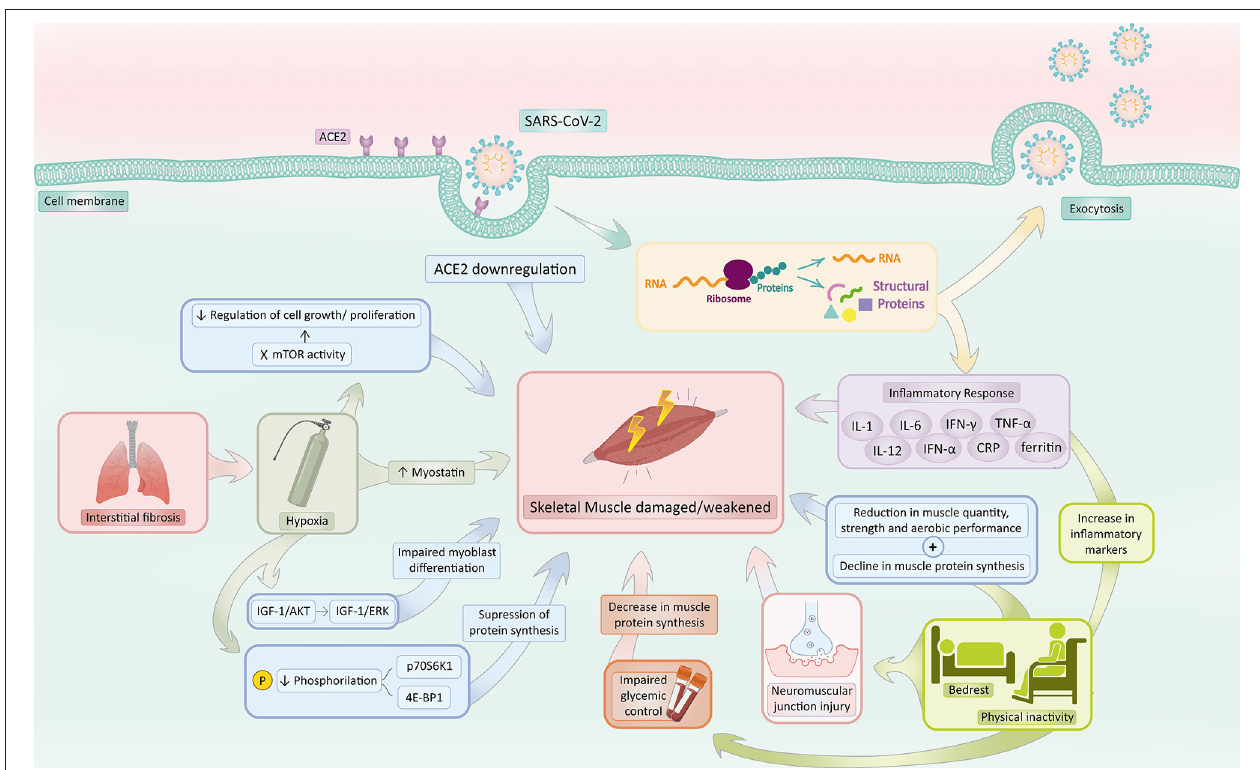
FIGURE 2 | COVID-19 associated sarcopenia mechanisms. SARS-CoV-2 infection activates a series of mechanisms responsible for increasing the risk of sarcopenia development. COVID-19 induces ACE2 downregulation and hinders the ACE2 protective effect, predisposing skeletal muscle to sarcopenia. The inflammatory response in response to infection, mainly characterized by the production of IL-1, IL-6, IFN- γ , TNF- α , IL-12, IFN- α , CRP, and Ferritin, prompts muscle catabolism, reducing muscle protein synthesis and increasing its susceptibility to damage and death. Bedrest and physical inactivity in the context of patients with COVID-19 not only increases several inflammatory biomarkers (such as TNF- α , CRP, and IL-6) but also reduces muscle quantity, strength, anaerobic performance, and protein synthesis. Additionally, the inactivity state impairs glycemic control, which also contributes to a decrease in muscle protein synthesis and damages neuromuscular junctions. Interstitial pneumonia secondary to COVID-19 commonly triggers a state of hypoxia , which accounts for (1) a decrease in phosphorylation of p70S6K1 and 4E-BP1, (2) a switch from the IGF-1/Akt to IGF-1/ERK signaling pathway, (3) an increase in myostatin levels and (4) an inhibition of mTOR. The decrease in phosphorylation of p70S6K1 and 4E-BP1 suppresses protein synthesis. The switch from the IGF-1/Akt to IGF-1/ERK signaling pathway impairs myoblast differentiation. Elevated levels of myostatin activate catabolism and negatively regulate muscle growth. Inhibition of mTOR activity hampers the regulation of cell growth and proliferation, which augments the risk of damage within the skeletal muscle. Hypoxia, thus, makes the musculoskeletal system susceptible to sarcopenia. Created with